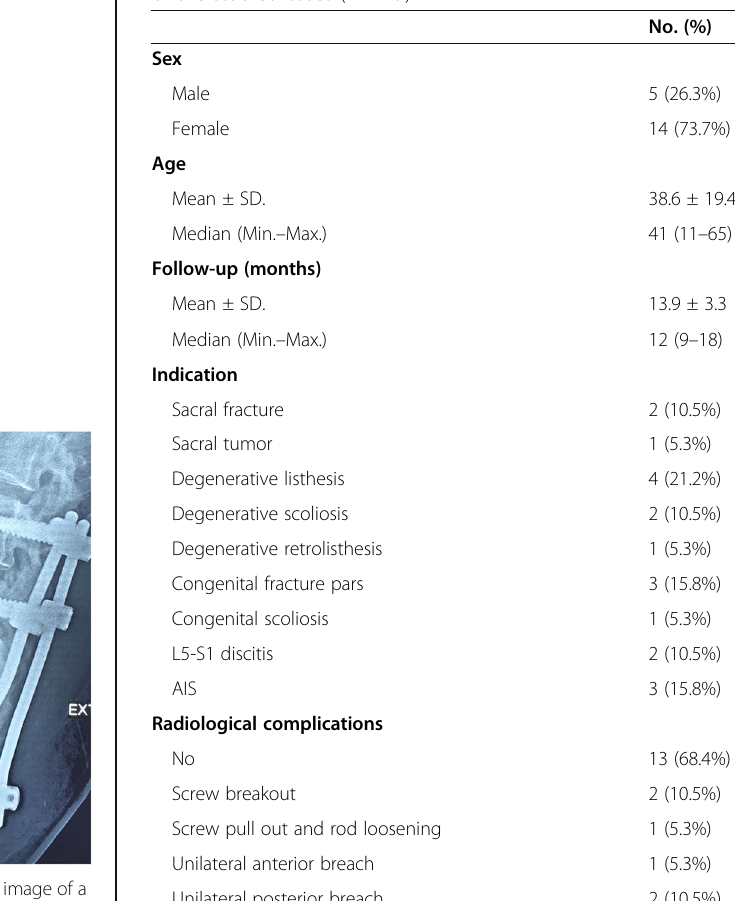
Table 3 Statistical analysis of the clinical and radiological data of the studied cases ( n =